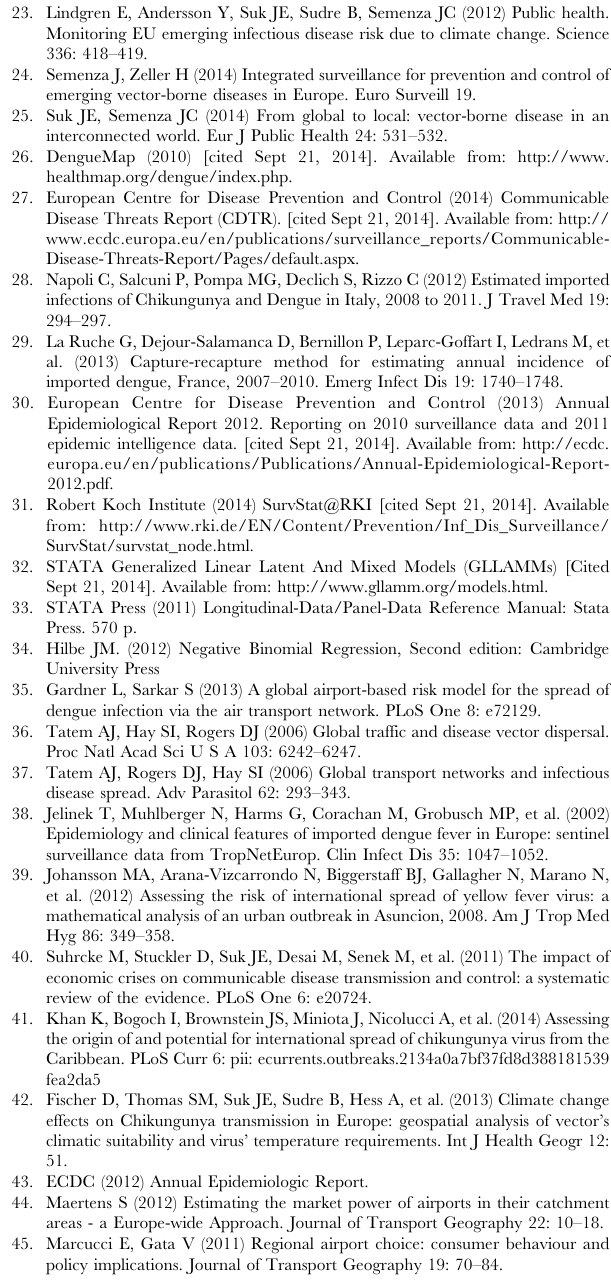
Figure S1 Projected airport-level final destination of interna- tional travellers from dengue affected areas by quarter for 2010, overlaid with the presence of Ae. albopictus , 2013. Figure S2 Scatter plot between numbers of imported cases observed and predicted count by the